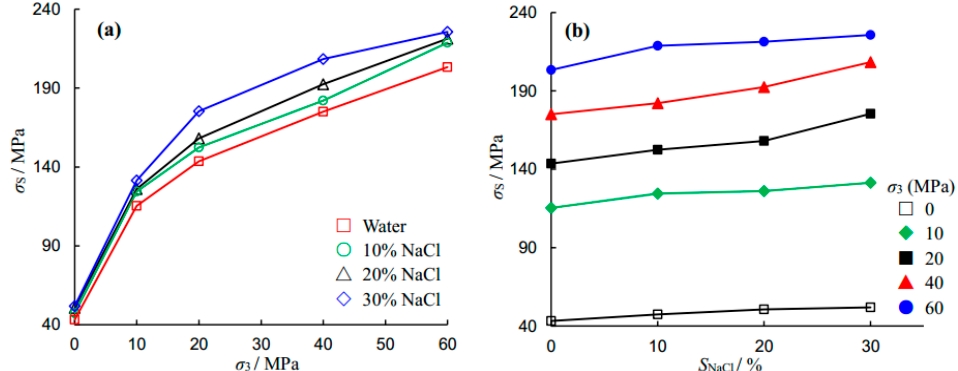
Figure 6. Effect of confining pressure and salinity on the peak strength of sandstone specimens. ( a ) Triaxial compressive strength versus confining pressure; and ( b ) Triaxial compressive strength versus salinity level. Note: σ S = σ p + σ 3 .